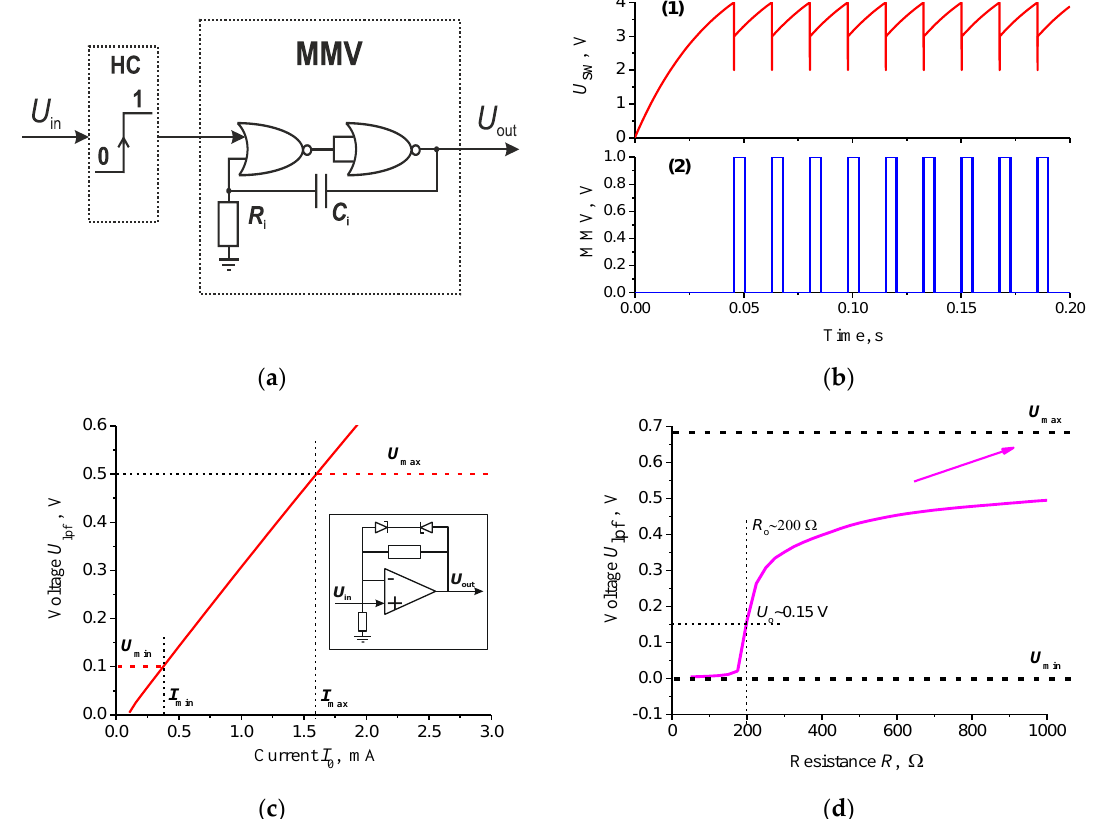
Figure 5. Monostable multivibrator (MMV) circuit with input Hit Crossing (HC) module ( a ): U in ≡ U sw ( t ), R i and C i —parameters of the RC chain. Voltage diagrams by example of OSC2 ( b ): U sw ( t ) ( 1 ) and pulses of MMV with τ p~ R i C i = 0.2 ms ( 2 ). The dependence of the output voltage U lpf of leaky integrated-and-fire (LIF) neurons with low-pass filter (LPF) and MMV modules on the supply current I 0 of OSC1 ( c ) and variable resistance R of OSC2 ( d ). The inset of Figure 5c shows an